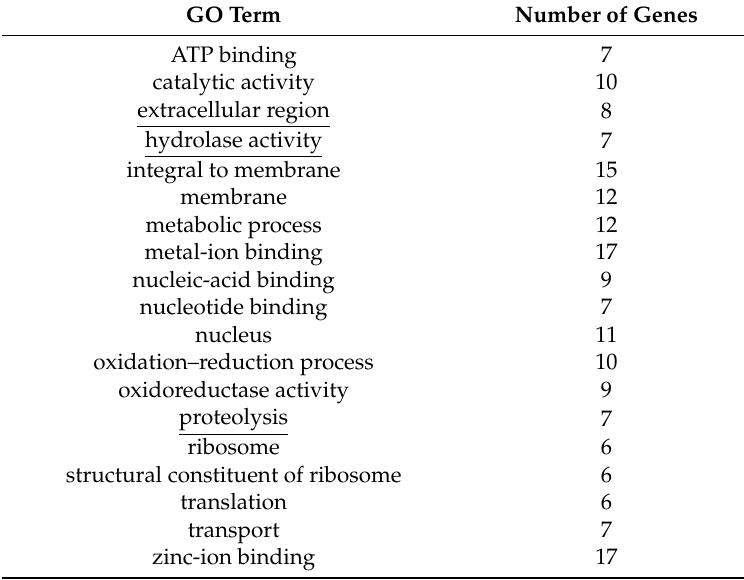
Table 2. List of gene ontology (GO) terms with significant ( p < 0.05) enrichment among the differentially expressed genes compared to all annotated genes in the genome. The terms underlined are enriched among the upregulated genes in T37 testes compared to the all the